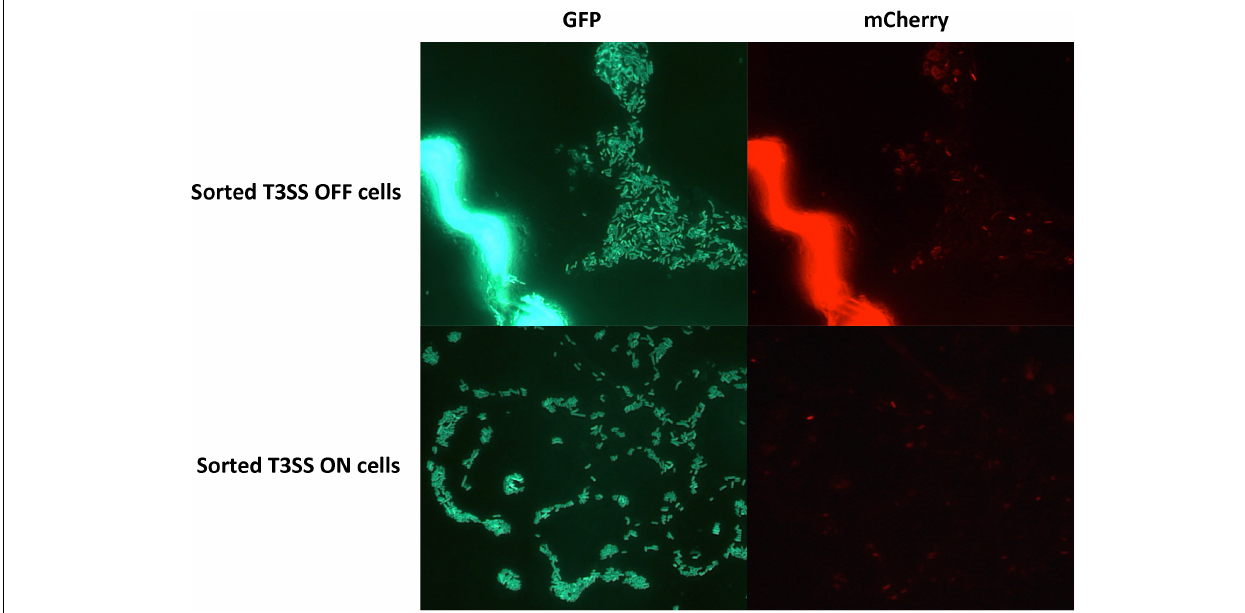
FIGURE 5 | Fluorescence microscopy observation of potato leaves inoculated with cells derived from the T3SS ON and T3SS OFF cells sorted by FACS. D. dadantii ( nptII-gfp-hrpN-mCherry ) were inoculated into potato leaves. At 24 h post-inoculation, leaf tissues with water soaking symptoms were dissected and macerated in PBS buffer to release bacterial cells. T3SS ON and T3SS OFF cells were sorted by FACS, recovered on agar plates, and were re-inoculated back into potato leaves. After 24 h, potato leaves inoculated with sorted T3SS OFF and T3SS ON cells were examined for green and red fluorescence using microscopy.